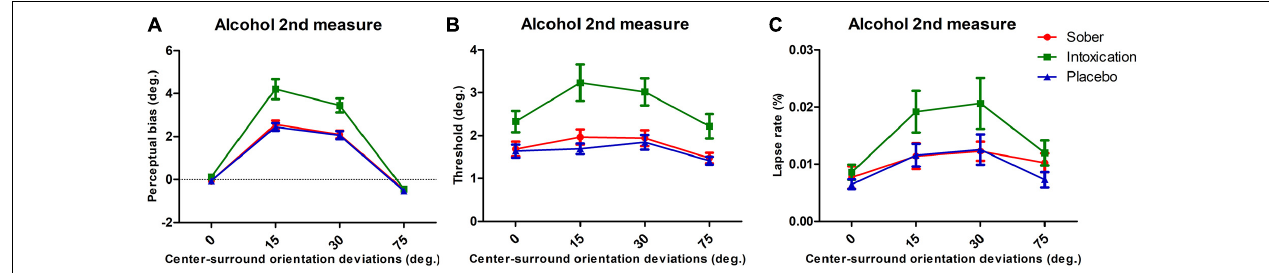
FIGURE 2 | Tilt repulsion results and lapse rates of sober (red), alcohol intoxication (green), and placebo (blue) conditions. (A) TI effects, indicated by the perceptual bias necessary to perceive the center as vertical, as a function of center-surround orientation deviations (positive values indicate tilt repulsion of the surround; the results for CW and CCW surrounds of same angular deviation were pooled). (B) Orientation thresholds around perceived verticality. The mean values for the vertical discrimination thresholds as a function of the experimental condition. (C) Lapse rates of various surround orientations. Error bars represent